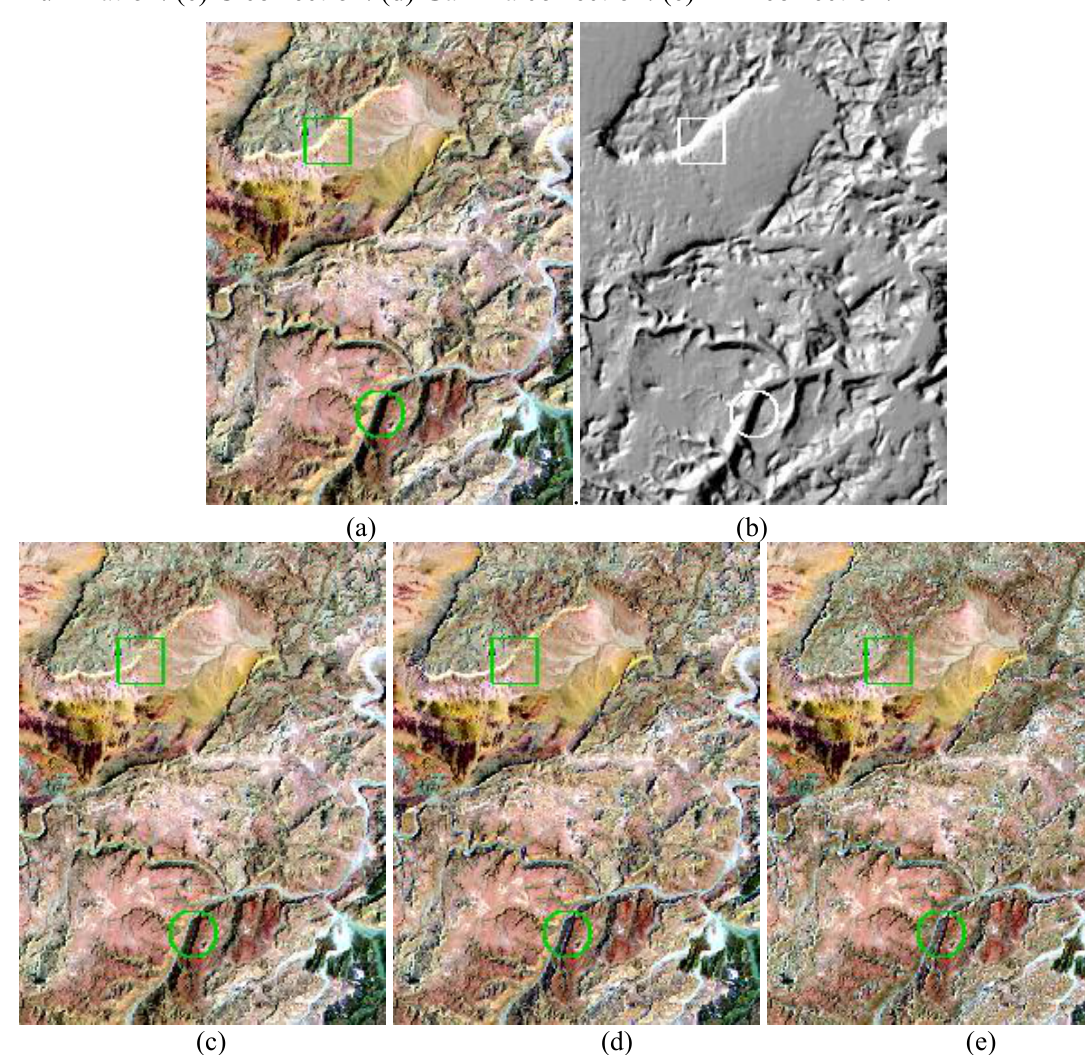
Figure 6. Sub-scene of (f), RGB = bands 7, 4, 1 (2200, 840, 480 nm. (a) Original. (b) Illumination. (c) C correction. (d) Gamma correction. (e) MM